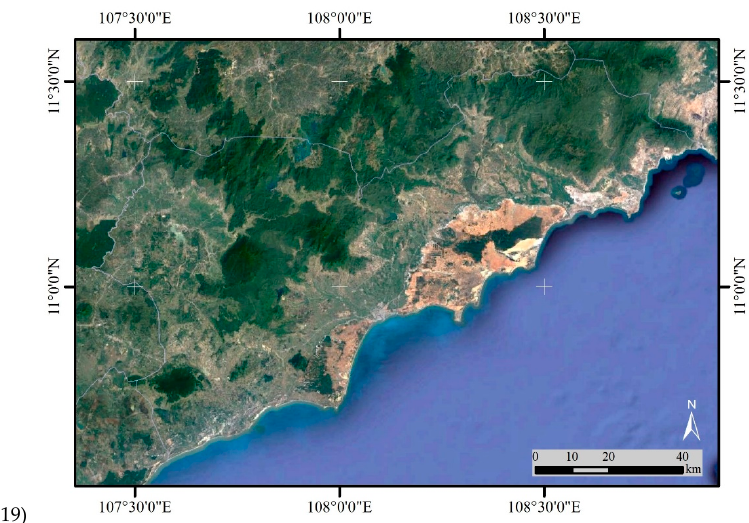
Figure A1. Landsat images of Binh Thuan province for selected years (1990–2019).